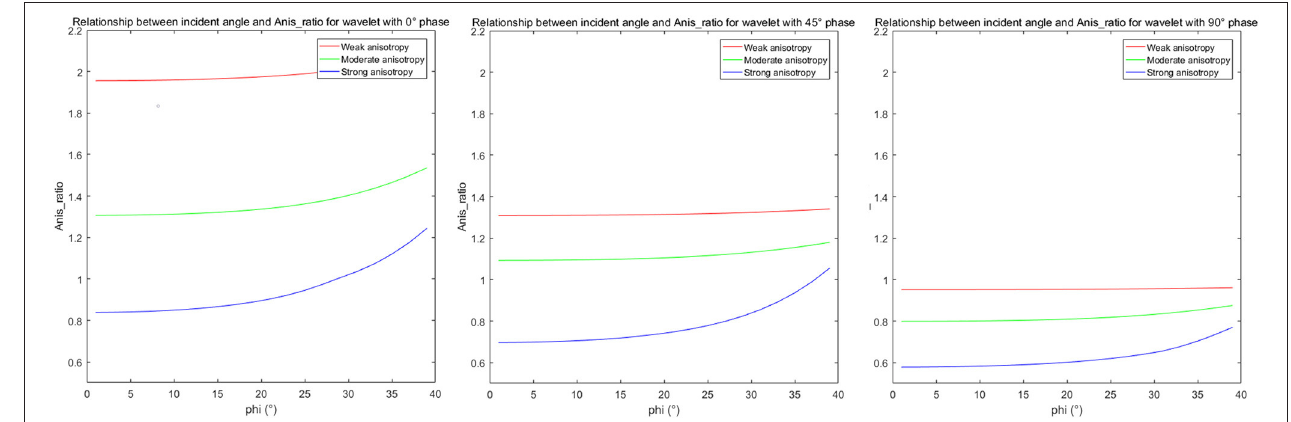
FIGURE 13 | Wavelet phase impact on anis_ratio.